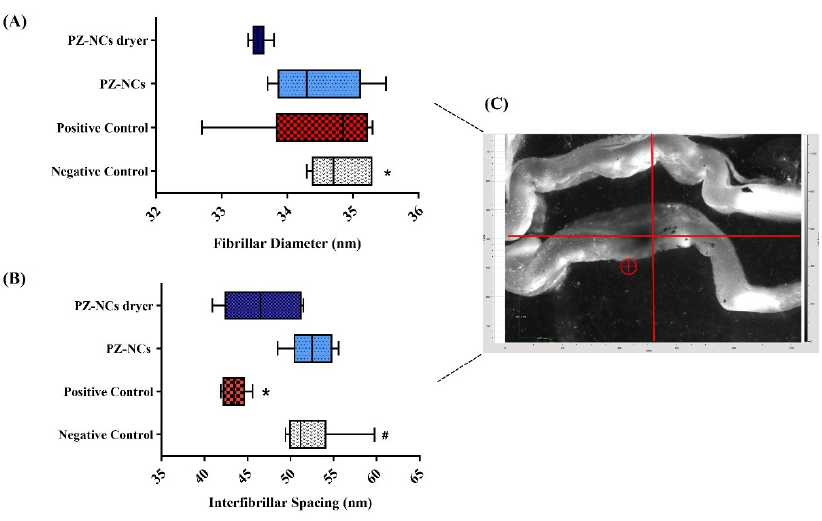
Figure 5. Series of data obtained from epithelium to endothelium in the center of the cornea (animal group, n = 4). Fibrillar diameter and interfibrillar spacing results using a box plot graph. Box: median, quartiles, and extreme values. Error bars: 95% confidence interval of the mean. ( A ) Fibrillar diameter; * p < 0.05 negative control vs. PZ-NCs dryer. ( B ) Interfibrillar spacing; * p < 0.05 positive control vs . PZ-NCs, # p < 0.05 positive control vs. negative control. ( C ) Image of the cornea positioned in the sample holder; the circle indicates the position of the beam.